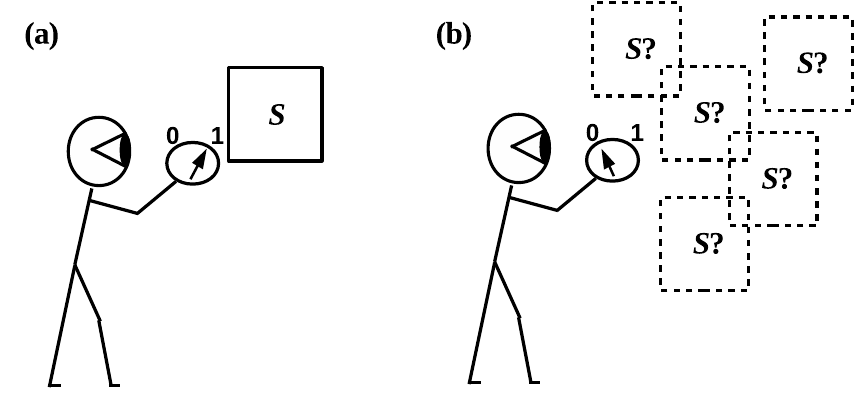
Figure 2. ( a ) Observers are standardly assumed to interact with a priori given systems, as in Figure 1. Here, the observer is equipped with an observable (e.g., a meter reading) with which to interact with the system S . Adapted from [35] Figure 1. ( b ) In practice, observers must look for the system of interest S by probing the “world” W in which it is